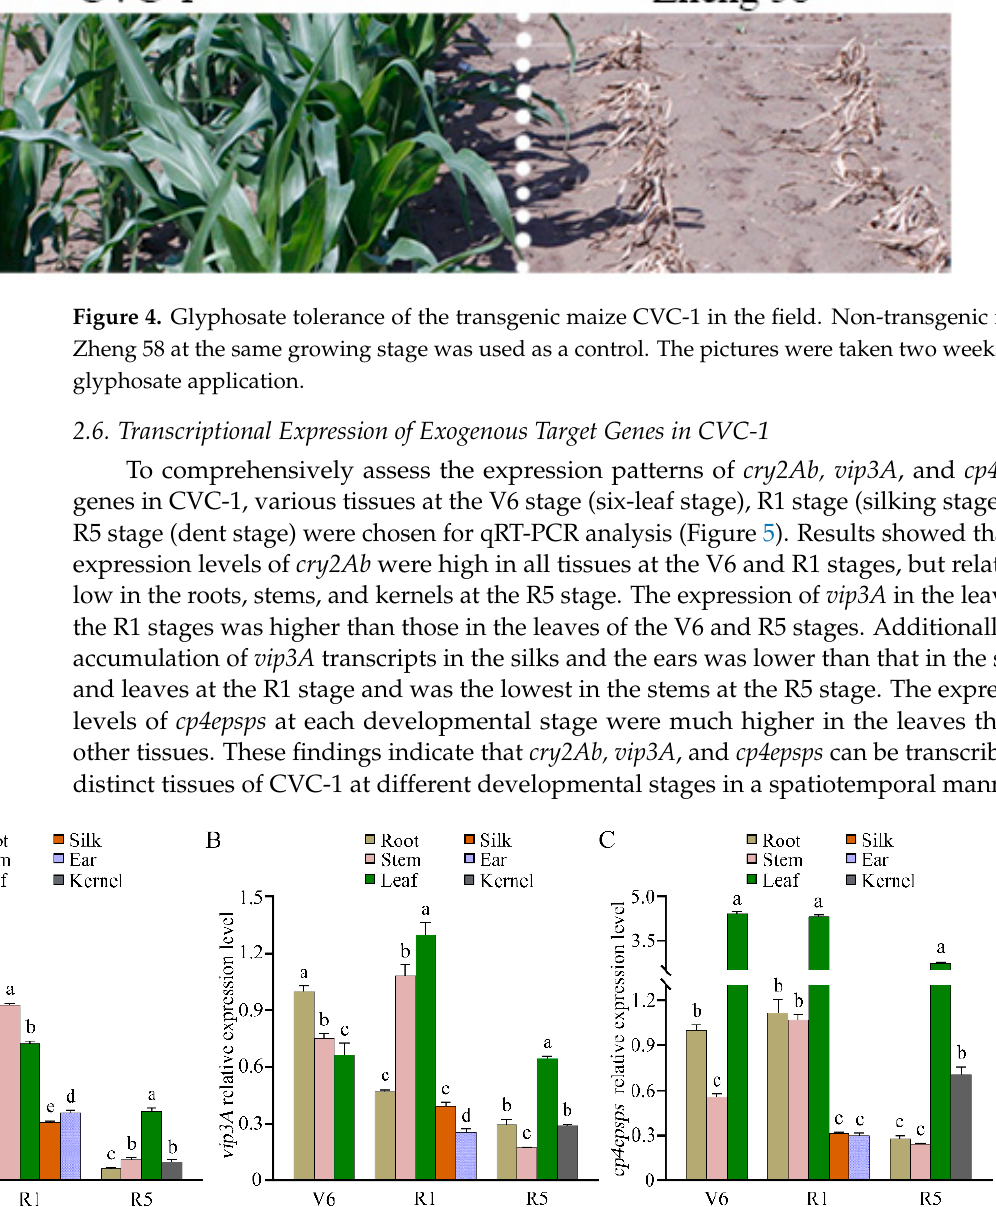
Figure 6. Protein expression levels of Cry2Ab ( A ), Vip3A ( B ), and CP4EPSPS ( C ) in the transgenic maize CVC-1. The data in all samples are presented as means ± standard deviation ( n = 3). Different lowercase letters indicate significant differences among the plant tissues at the same developmental stages with Duncan’s multiple range test (one-way ANOVA; p < 0.05). FW, fresh weight of tissue.